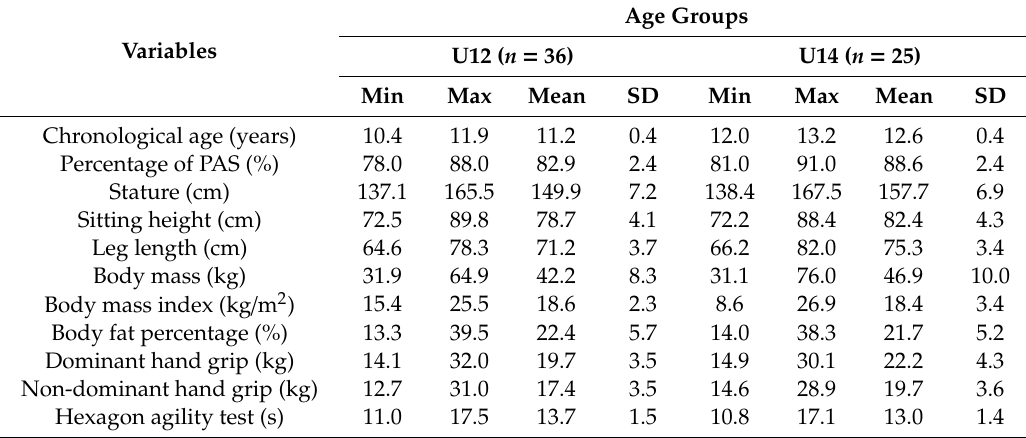
Table 1. Descriptive statistics (minimum, maximum, mean and standard deviation) of the chronological variables, anthropometric profile and physical fitness tests by age